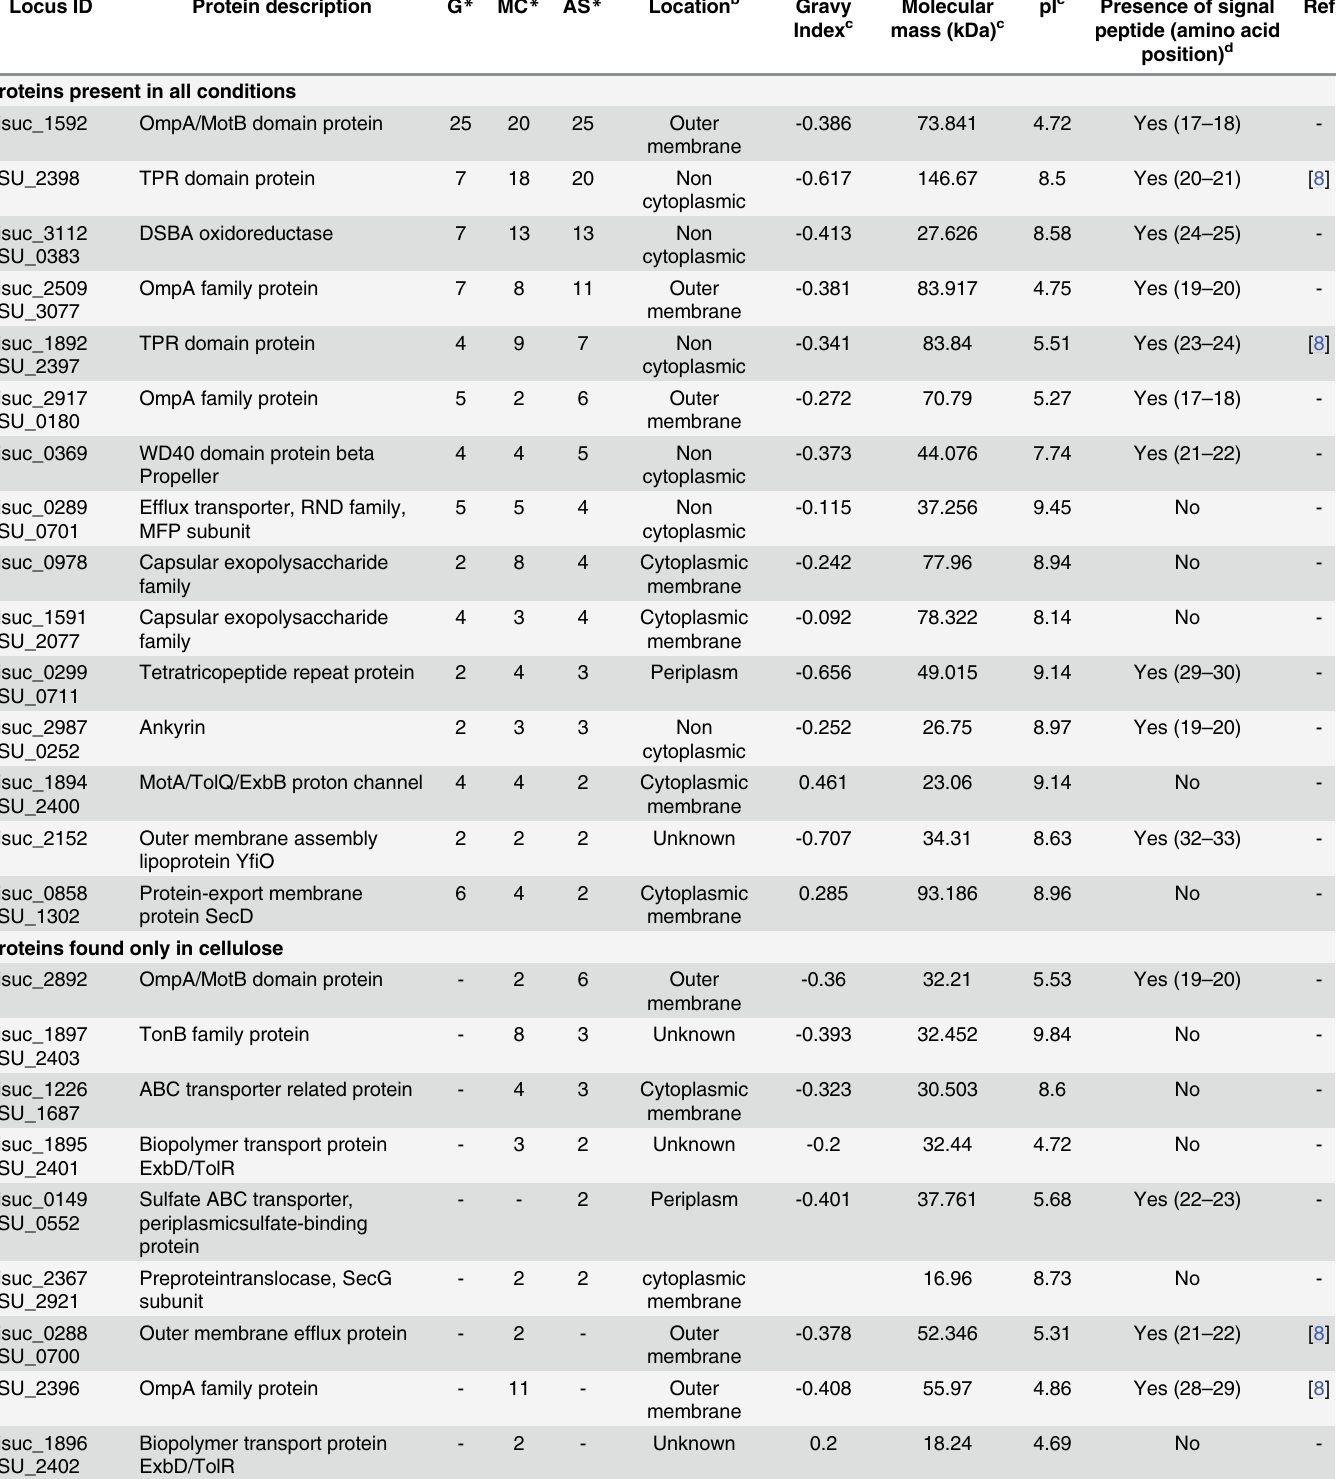
Table 2. List of predicted cell envelope proteins associated with ion conductivity, transportation, signal transduction and protein-protein interac- tion in F . succinogenes S85. Locus ID